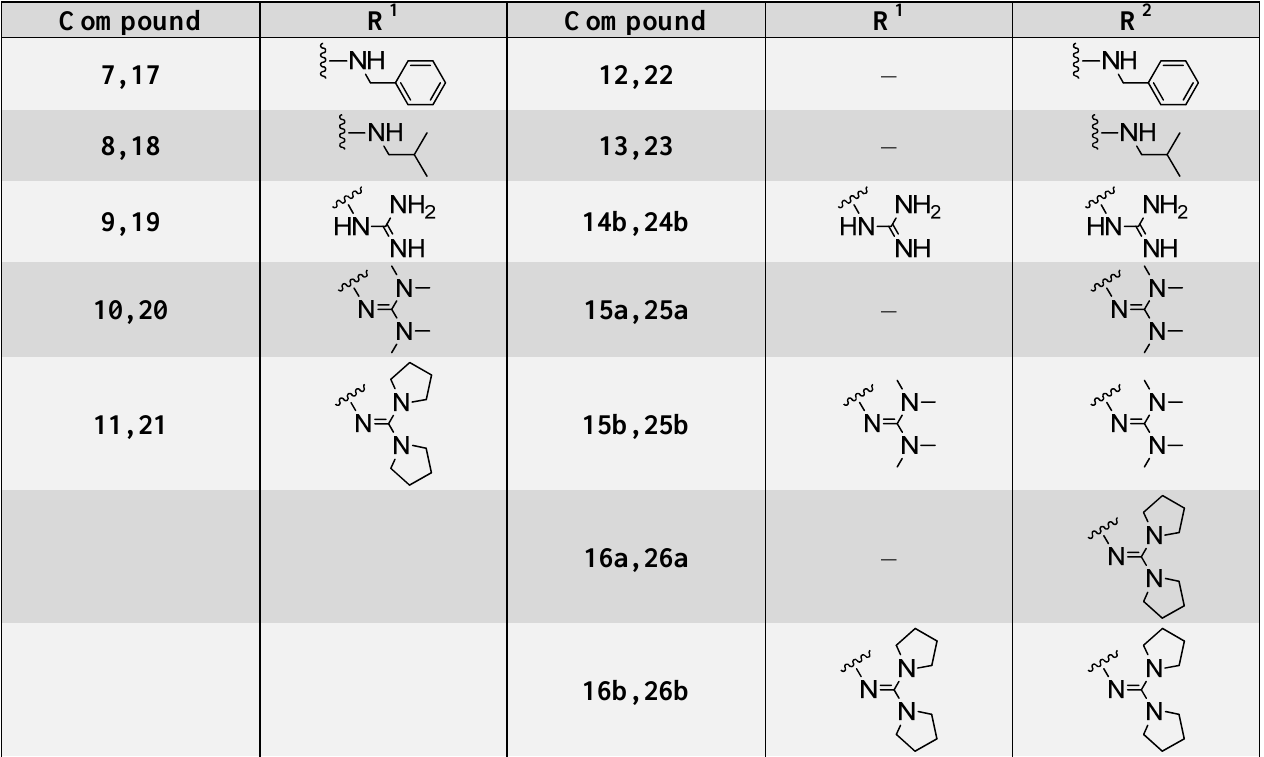
Table 1. Final compounds and intermediates